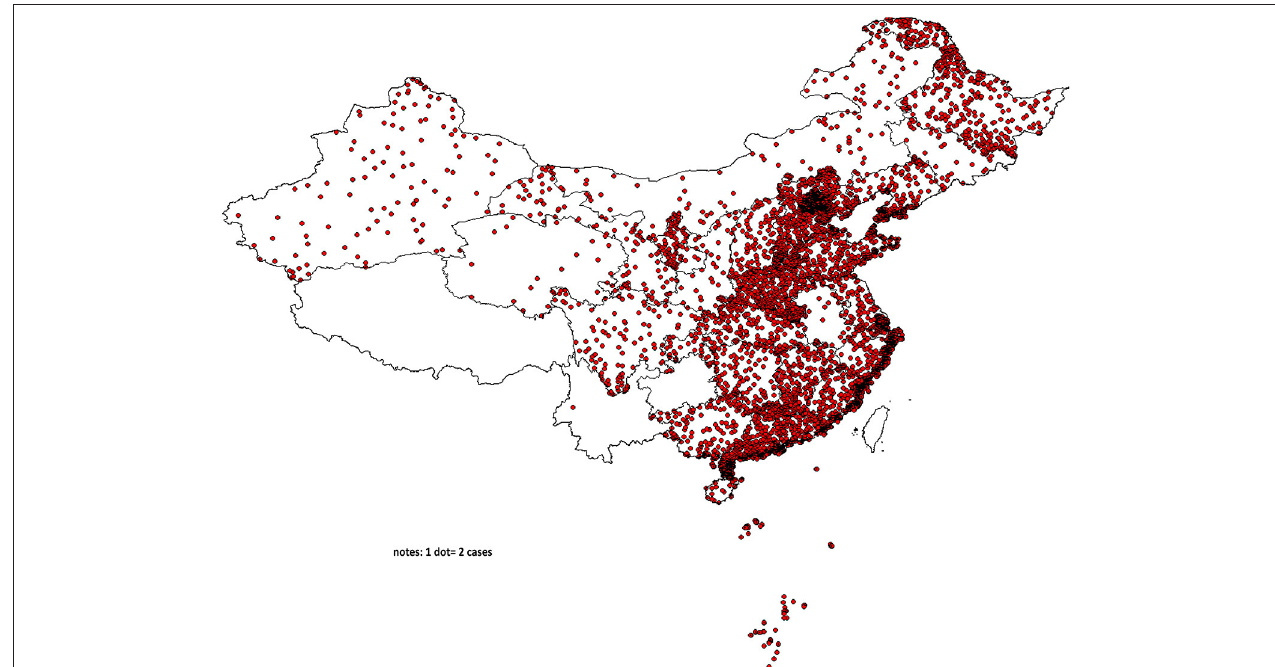
FIGURE 1 | Regional distribution of information collection for 4529 patients in